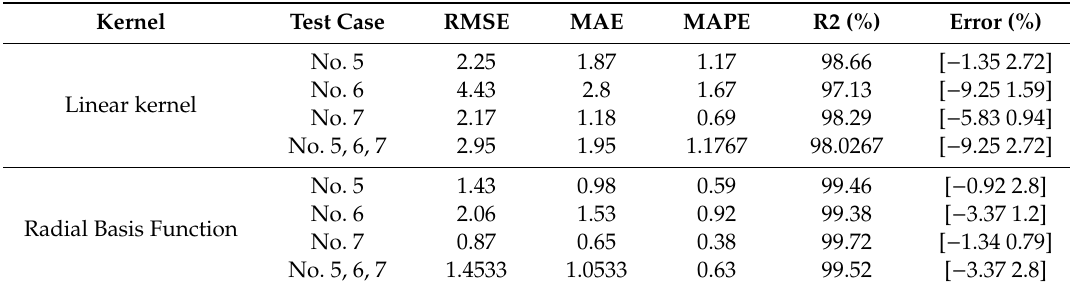
Table 6. Statistical results of SOH